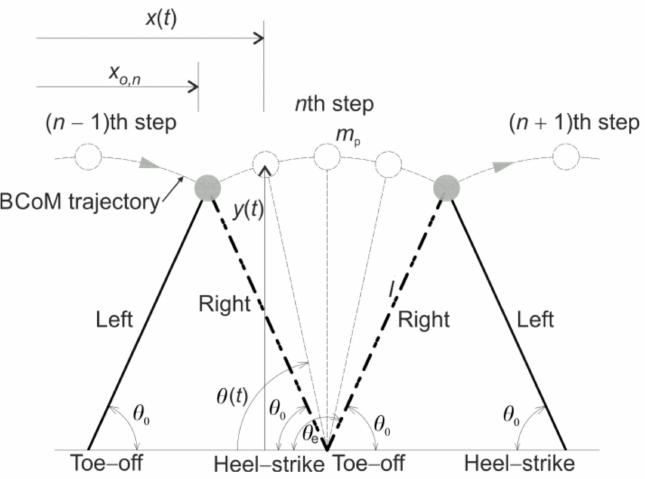
Figure 6. Inverted pendulum